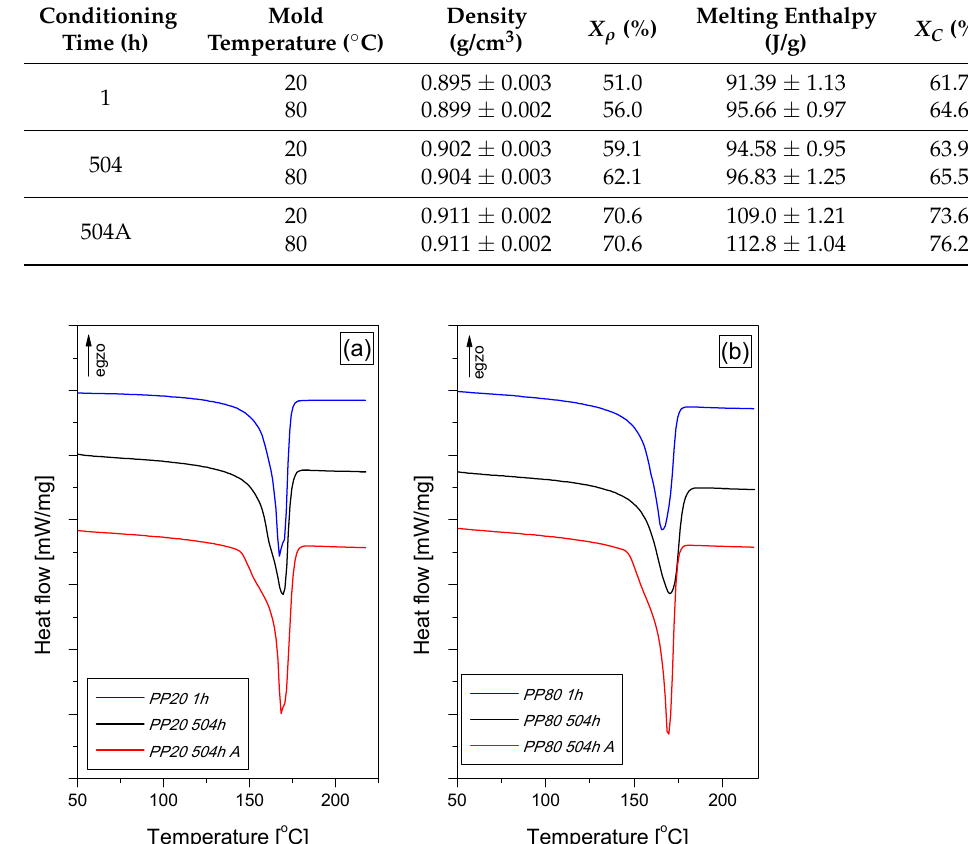
Table 3. Physical properties of PP samples in the function of conditioning time.